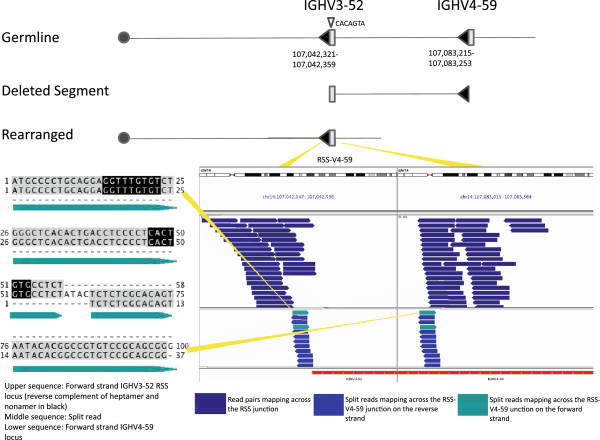
An interstitial deletion within the IGH locus variable domain of the DB cell line. The deletion involves a 41 kb segment flanked by two RSS sequences with 23 bp spacers (filled arrows). The deletion was likely mediated through V replacement, although this allele has not undergone prior rearrangement at this locus. The deletion is initiated through recognition of an oppositely oriented cryptic heptamer (shown as a small downward facing, open triangle) within IGHV3-52 by the RSS of IGHV4-59. The deletion was detected by sequencing of the RSS-V4-59 junction (lower right panel); blue reads denote sequences with read pairs mapping across the junction. The rearrangement was confirmed by Sanger sequencing, with the recovered sequence matching the junction spanning sequence found with a split-reads (left lower panel, middle sequence). The split-reads sequence is shown aligned to the two sequences present in the reference genome (hg19). Nucleotides aligning to the reference regions are shown in gray, N-region nucleotides are white, and the reverse complement of the retained heptamer and nonamer of IGHV3-52 are shown in black.